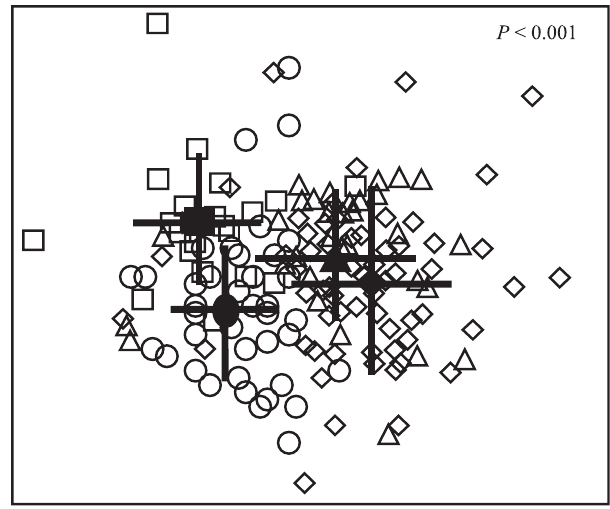
Fig. 2. Multi-dimensional scaling (MDS) ordination depict- ing the relative similarity of assemblage composition. Each open symbol on the graph represents one sample (i.e. 3 gill nets set for 24 hours), and the closed symbols are sample means for each of the four habitat types. Error bars are 1 S.D. Channel = squares; sand bank = circles; creek = triangles; lagoon =